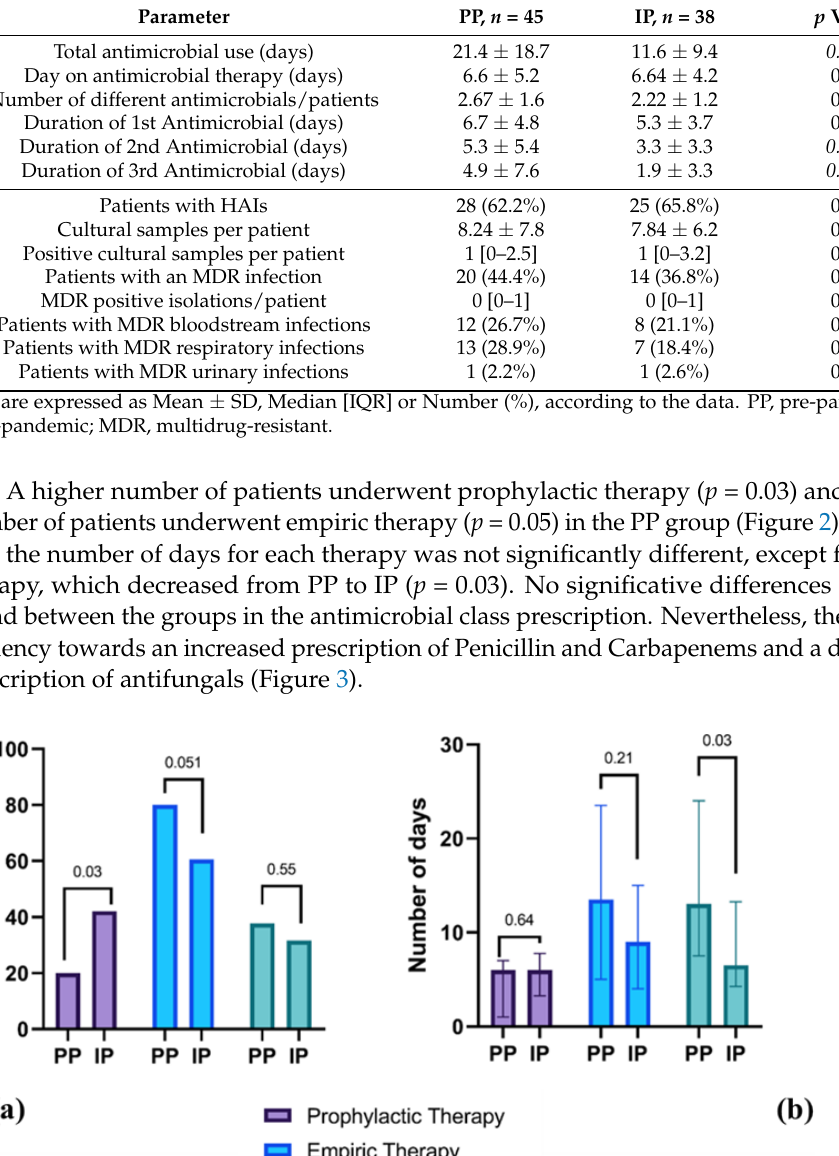
Figure 3. Antimicrobial classes and relative percentages regarding every administered drug in the two years of analysis (pre-Pandemic and intra-pandemic). 3.4. Cultural Isolations There were no significant differences between the two groups in the number of cultural samples/patient, positive cultural samples/patient and number of patients developing HAIs and MDR infections, as shown in Table 3. Microbial isolations in blood, respiratory tract and urinary tract were divided in families and differences are summarized in Table S2 and Figure S1. The only significant difference between PP and IP